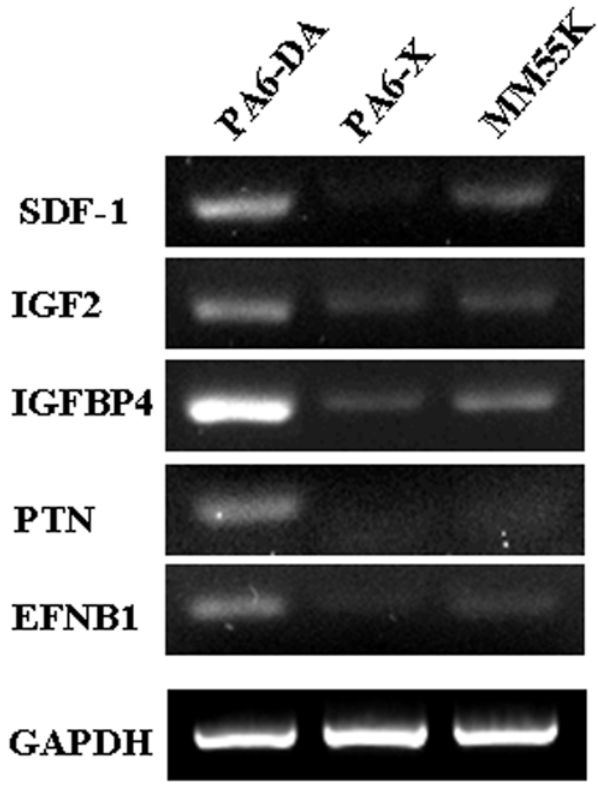
Figure 2. Confirmation of microarray results by RT-PCR. cDNA of PA6-DA, PA6-X and MM55K cell lines were analyzed by RT-PCR using gene specific primers for the five candidate genes selected from the microarray data. RT-PCR analysis reproduced the results of cDNA microarray for all five genes, including SDF-1, IGF2, IGFBP4, PTN, and EFNB1. Amplification was performed for 35 cycles. GAPDH was amplified simultaneously as an internal control under the same